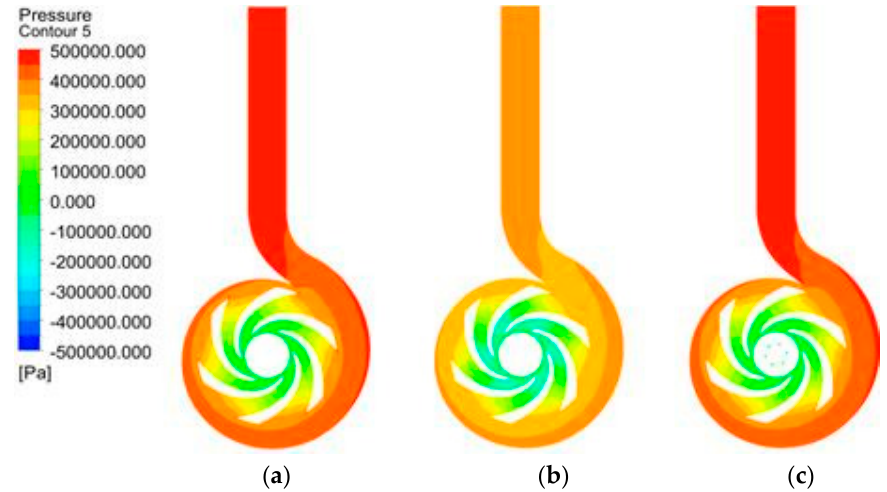
Figure 11. Comparison of the pressure contour distribution on the X – Y plane of the pump without balancing holes and the pumps with six Type A and B balancing holes of 4 mm diameter: ( a ) without balancing holes; ( b ) with Type A balancing holes; ( c ) with Type B balancing holes.